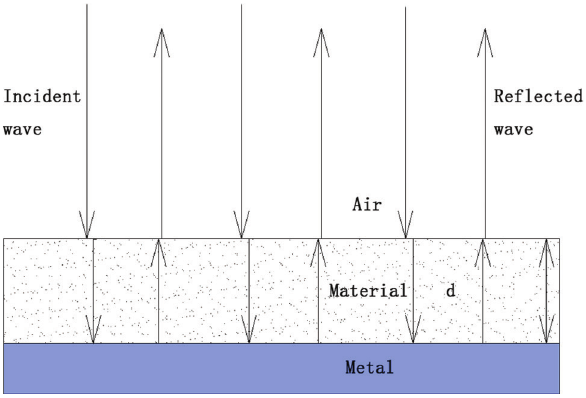
Fig. 1: Schematic of a single-layer absorber under microwave irradiation